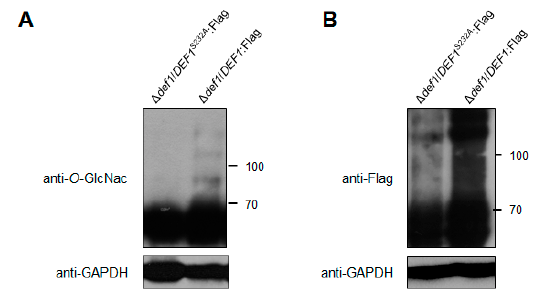
Figure 8. O -GlcNAc modification affects the Def1 stability. ( A ) The O -GlcNAcylation level of Def1 protein with and without the mutation of O -GlcNAc site. Fusion protein DEF1 S232A :Flag and DEF1:Flag were extracted from ∆ def1 and were immunoprecipitated by anti-Flag Beads, and then blotted with O -GlcNAc antibody. ( B ) Protein level of Flag fused Def1 with and without the mutation of O -GlcNAc site. Total proteins from extracts of ∆ def1 / DEF1 S232A :Flag and ∆ def1 /DEF1:Flag were detected by anti-Flag antibody.